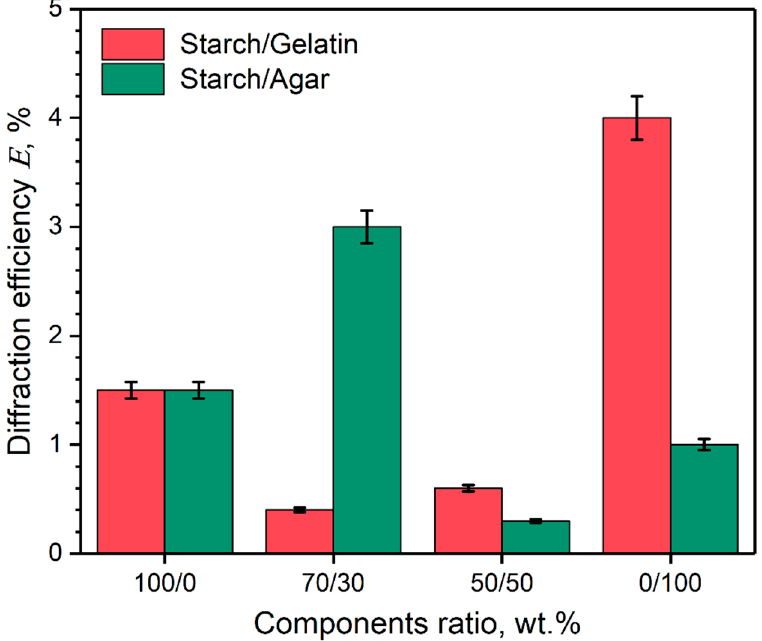
Figure 5. Diffraction efficiency of the holographic markers on the coating surface depends on their